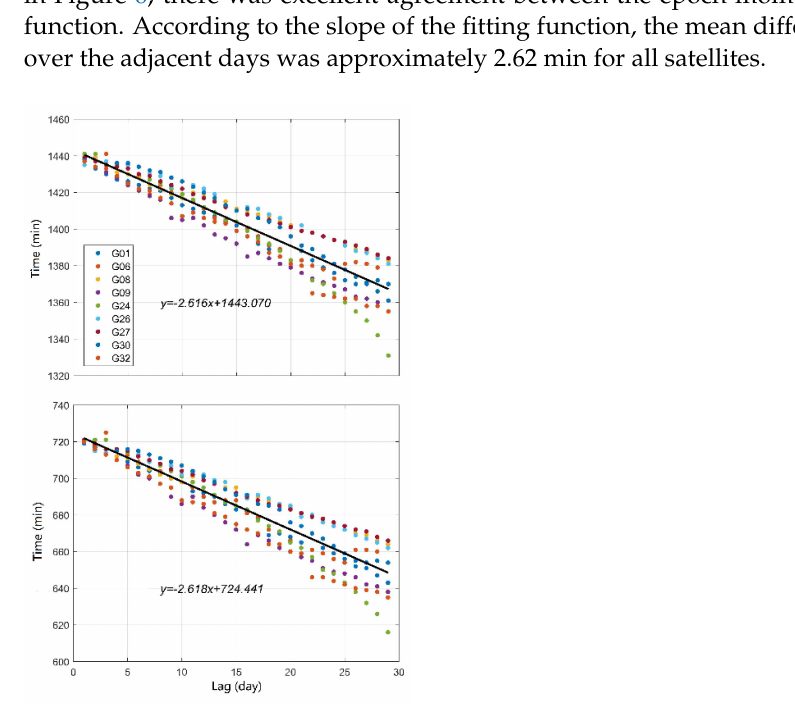
Figure 6. Epoch moments corresponding to the primary peak (top) and secondary peak (bottom) of the autocorrelation